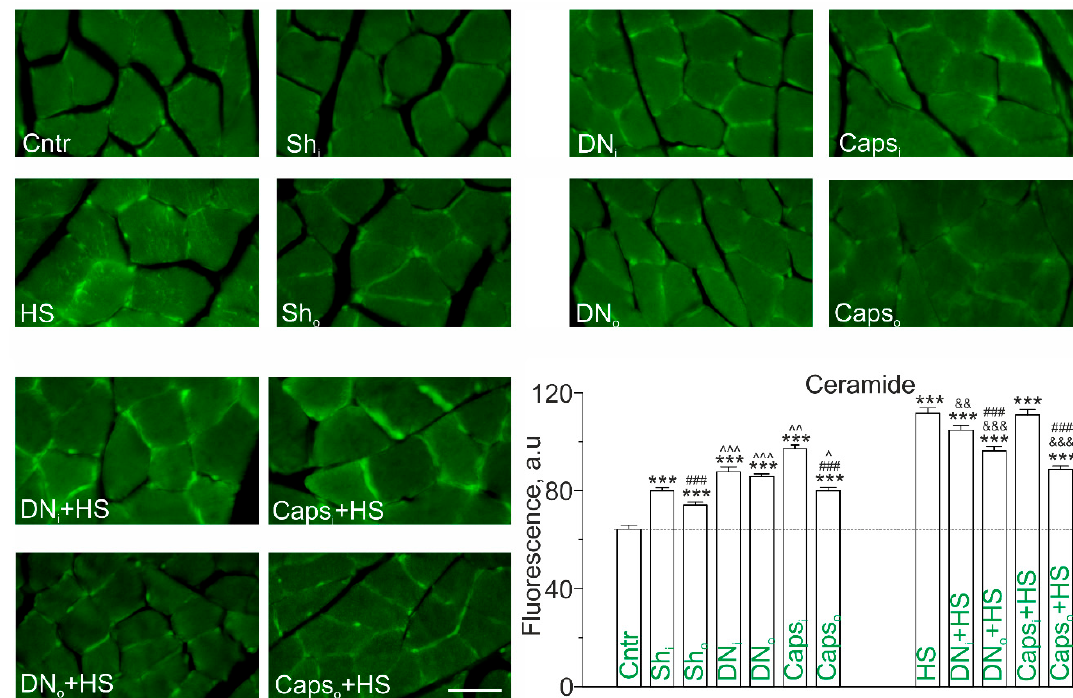
Figure 2. Cer immunoexpression in soleus muscle of HS, unilaterally denervated (DN) or capsaicin (Caps) treated rats. The assay was carried out 5 days after unilateral surgical denervation (DN) or application of Caps on the sciatic nerve. In the experiments with 12-h muscle unloading, DN or Caps deafferentation were performed 5 days before HS. Immunofluorescent images: transverse sections of soleus muscle stained with anti-Cer antibodies. Scale bar—10 µ m. Graph: quantification of plasma membrane fluorescence (mean ± SEM); N = 4 in each group. *** p < 0.001—differences compared to control; ˆ p < 0.05, ˆˆ p < 0.01, ˆˆˆ p < 0.001—differences compared to sham-operated rats; ### p < 0.001—differences between intact and operated limb. && p < 0.01, &&& p < 0.001. p was evaluated by a two-way ANOVA followed by Bonferroni post hoc comparisons. Sh i , DN i , Caps i and Sh o , DN o , Caps o —intact and operated limb, respectively.